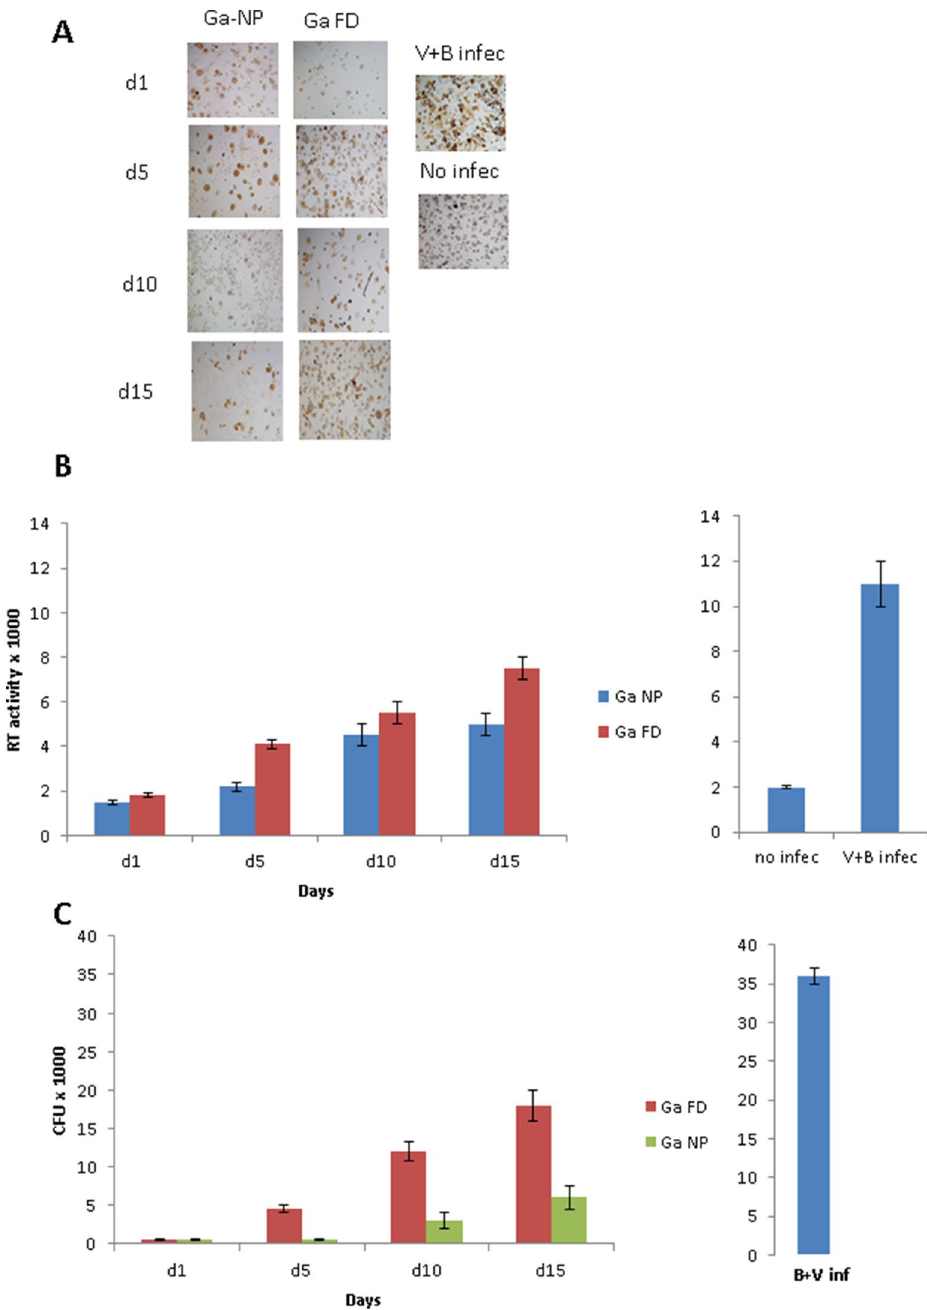
Figure 3. Activity of Ga-NP against co-infections.( A ). Prolonged activity of Ga-NP against HIV- mycobacterium co-infection; intensity of HIV infection was tested by p24 staining. Ga-NP was able to reduce the HIV growth similar to the individual HIV infection up to 15 days. ( B ). Prolonged activity of Ga-NP against HIV-mycobacterium co-infection; intensity of HIV growth was tested by reverse transcriptase activity assay. There was less than 1% growth on days 1 and 5 for Ga-NP loaded macrophages. On day 15 around 25% growth of HIV was seen, better than free Ga particles. Data are analysed using the t-test. Data are shown as mean +/− s.e.m. for n = 9, P < 0.05. ( C ). Prolonged-acting property of Ga-NP against HIV-mycobacterium co-infection; mycobacterium growth was measured by CFU counting. Ga nanoparticle showed 7-fold less growth even after 15 days of single drug loading. Data are analysed using the t-test. Data are shown as mean +/− s.e.m. for n = 3, P <